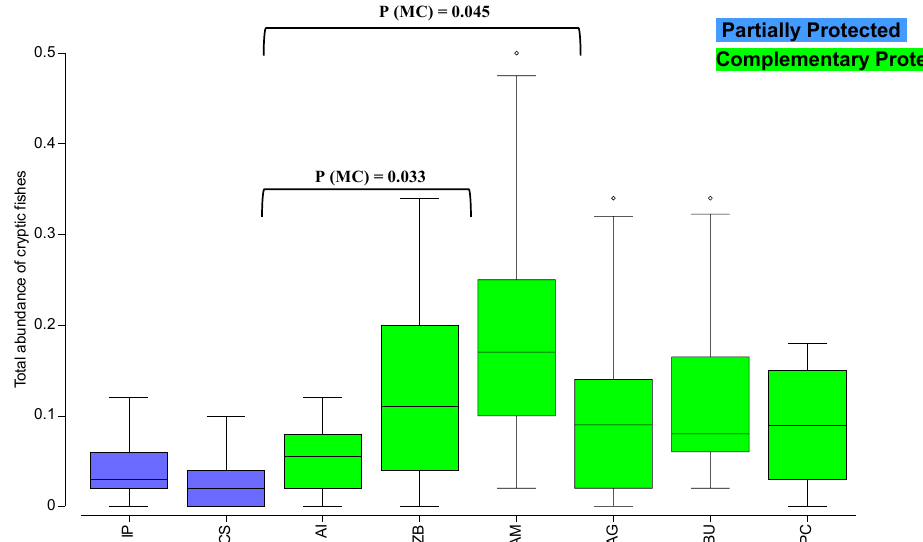
Figure 6. Spatial variation of the total abundance of cryptic fishes (boxplot; nº/m 2 ) in the partially protected areas of “Ilha do Pessegueiro” (IP) and “Cabo Sardão” (CS) and in adjacent control areas (complementary protection areas; Burrinho (BU), Porto Covo (PC), Aivados (AI), Almograve (AG), Zambujeira (ZB), and Amália (AM)) of the northern marine PNSACV. Pairwise tests showed significant differences between AI and AM and between AI and ZB, as indicated.